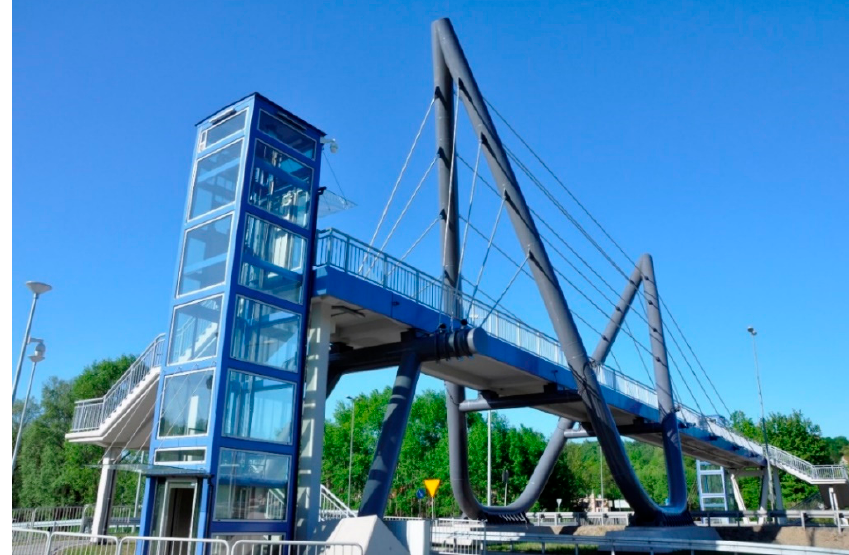
Figure 1. The general view of the three-span cable-stayed footbridge.